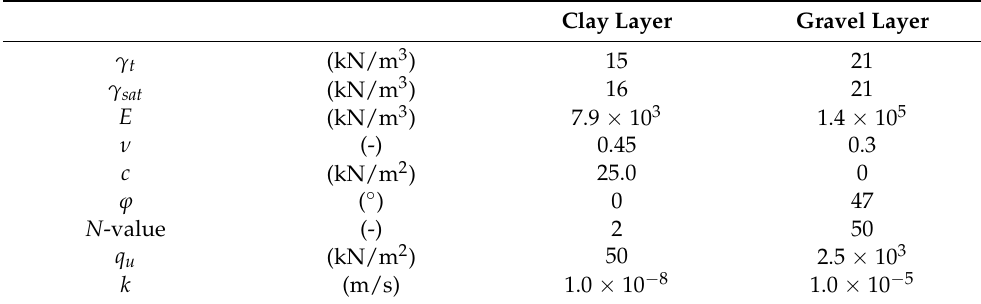
Table 1. Parameters of the surrounding ground used for the analysis.